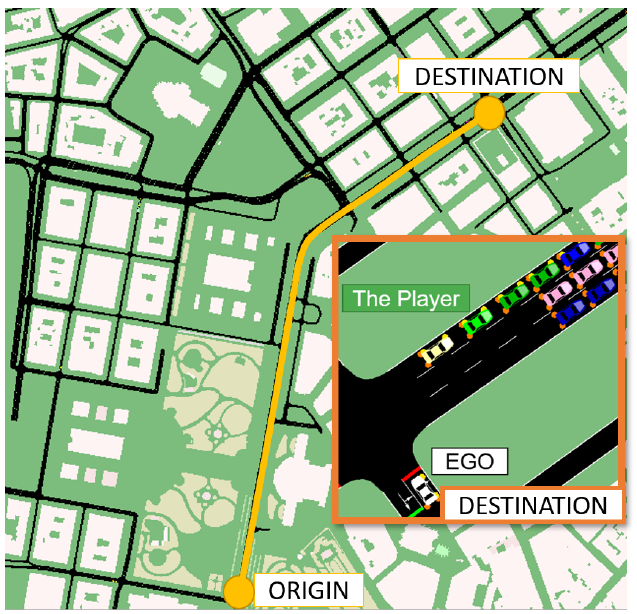
Figure 10. Trip origin and destination on the generated Simulation of Urban MObility (SUMO) road network to perform the model validation with a section of the generated SUMO simulation with different vehicle types at the